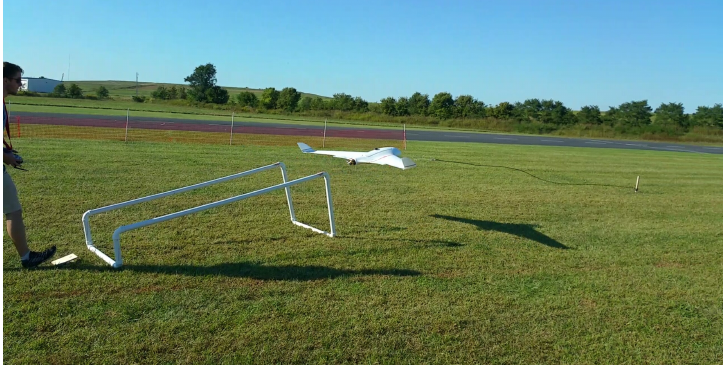
Figure 1. BLUECAT5 takeoff with